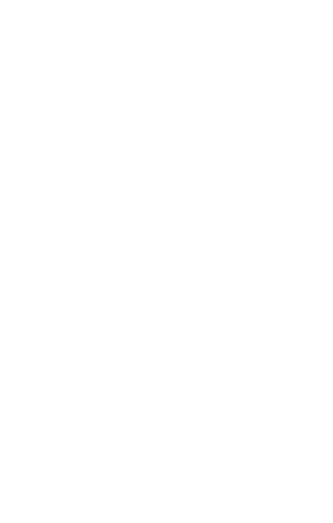
Figure 4. Reactive centre loop P14 residue. The P14 residue in CBG (PDB entry 2VDY [19]), Val 336, shown in yellow spheres, is believed to displace Tyr 235 (blue spheres) on the s2B/s3B loop when the reactive centre loop is inserted into the central b -sheet A (red), leading to conformational changes in the binding pocket (pale green). CBG’s interaction with cortisol is provided by a network of side chains (bright green ball-and-stick representation), which can be perturbed by any slight movement in the pocket and its surrounding regions.